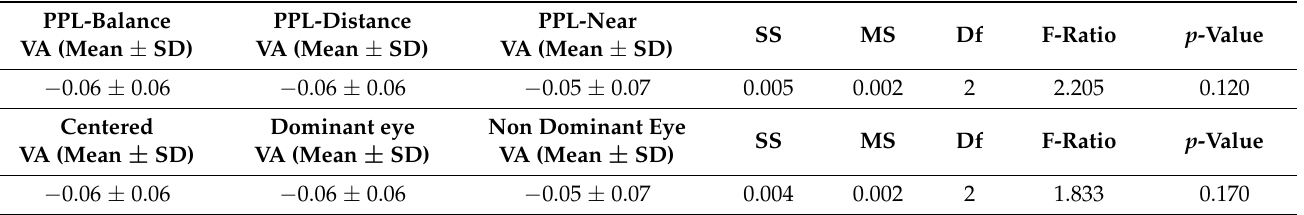
Table 1. Detailed statistics for visual acuity (VA) analysis at distance vision. Two-way repeated measures ANOVA.